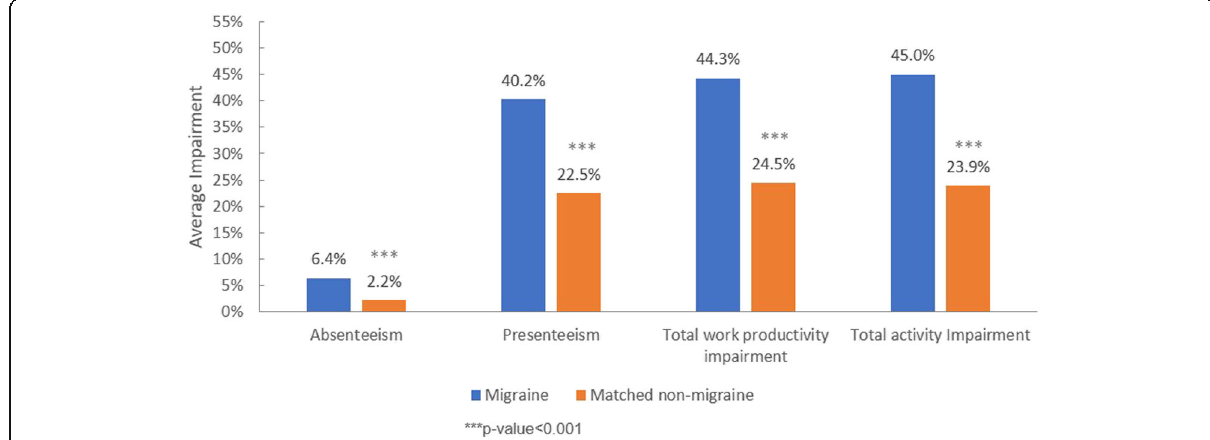
Fig. 2 Adjusted means of work productivity and activity impairment (WPAI) for migraine patients and matched non-migraine respondents. Adjustment for following covariates: age, gender, CCI, marital status, education, household income, region, insurance type, employment